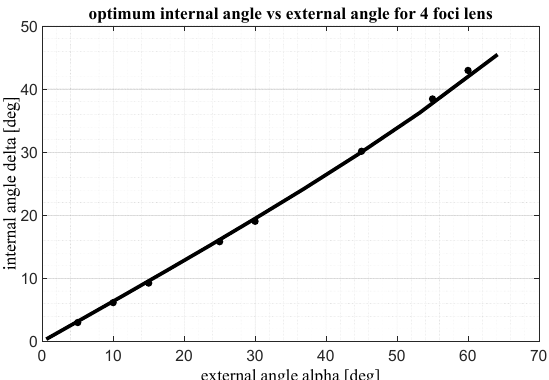
Figure 4. Optimized internal angle δ [degrees] in the 4-focus lens as compared to the external angle α [degrees]: dots = numerical evaluations, black continuous line = heuristic curve (6).